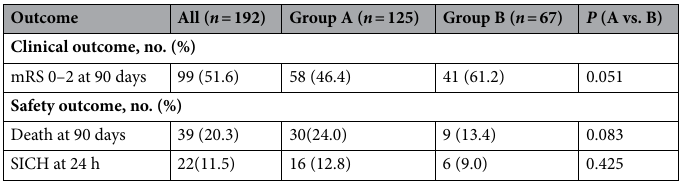
Table 2. Clinical outcomes. SICH symptomatic intracranial hemorrhage, favorable outcome, mRS 0–2.